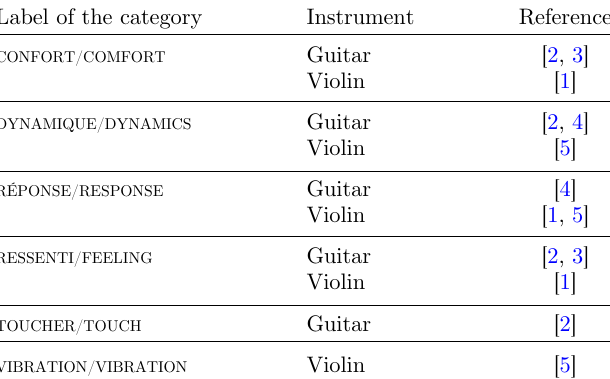
Table 1. Articles using the words chosen for this work. Label of the